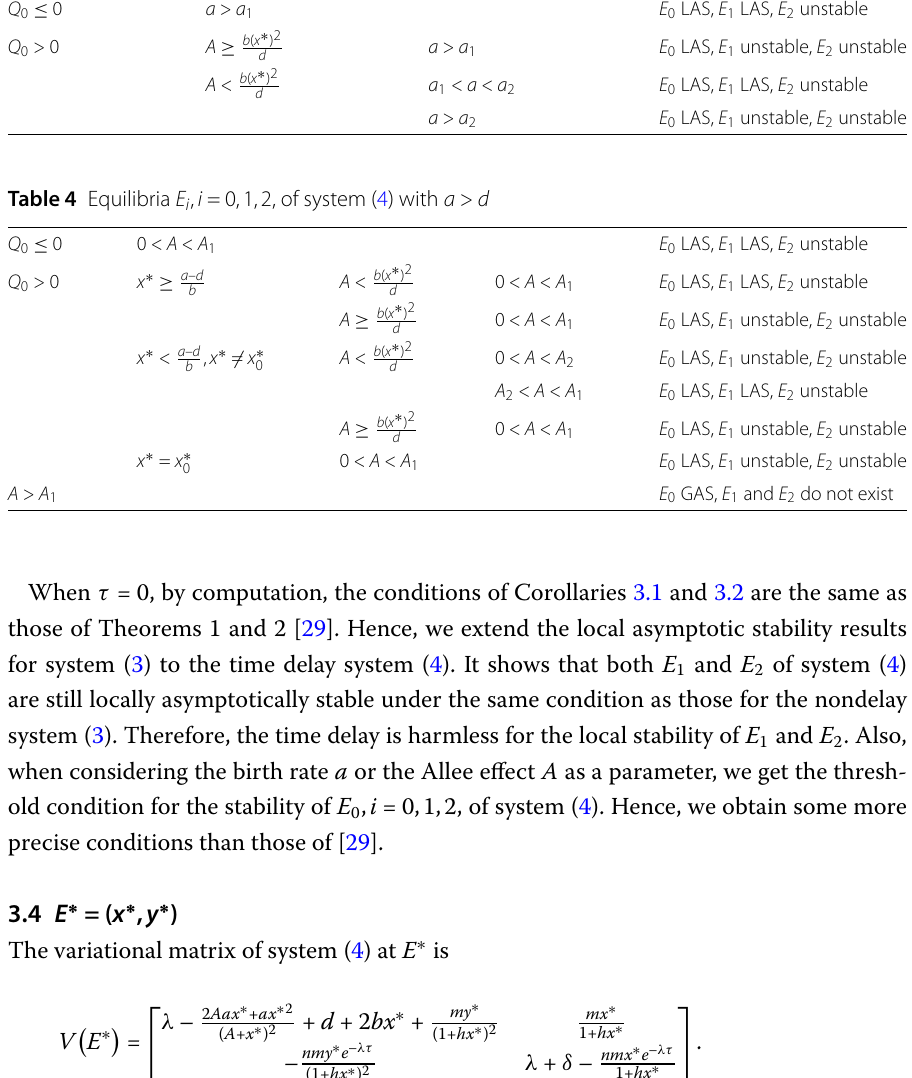
Table 3 Equilibria E i , i = 0,1,2, of system (4) 0 < a < a 1 E 0 GAS, E 1 and E 2 do not exist Q 0 ≤ 0